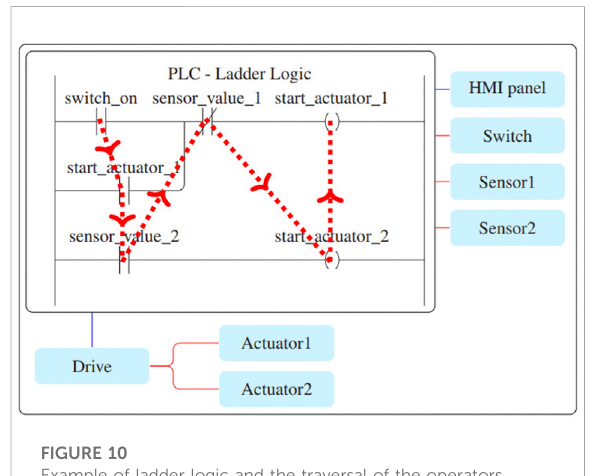
FIGURE 10 Example of ladder logic and the traversal of the operators.